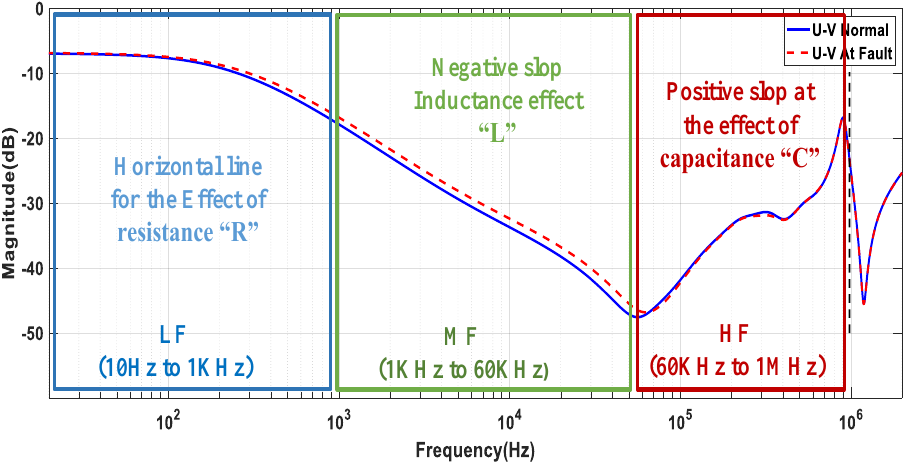
Figure 8. The proposed FRA sub-bands for IM FRA studies.